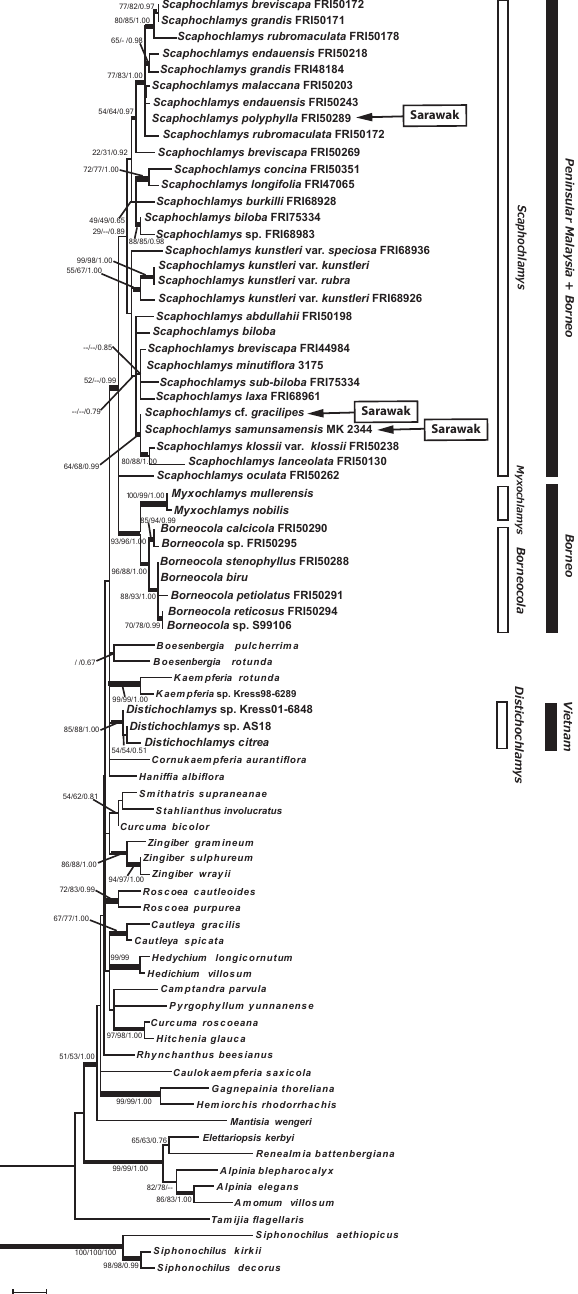
Figure 2. Molecular phylogenetic analysis of the matK sequence data by the Maximum Likelihood method. Numbers above branches indicate bootstrap values of ML and MP and posterior probability of Bayesian